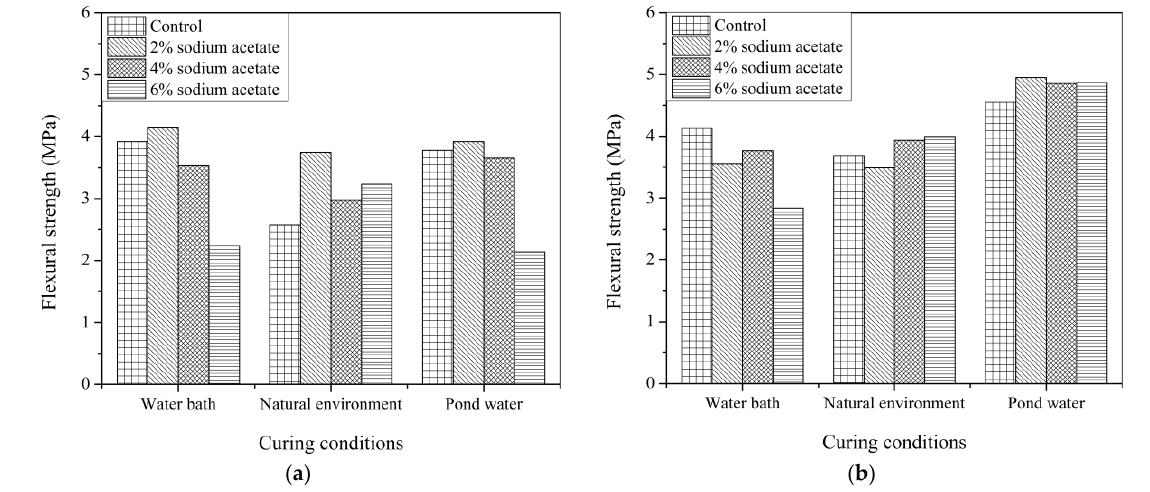
Figure 5. Flexural strength properties of PCC pavement when cured for: ( a ) 7 days and ( b ) 28 days.